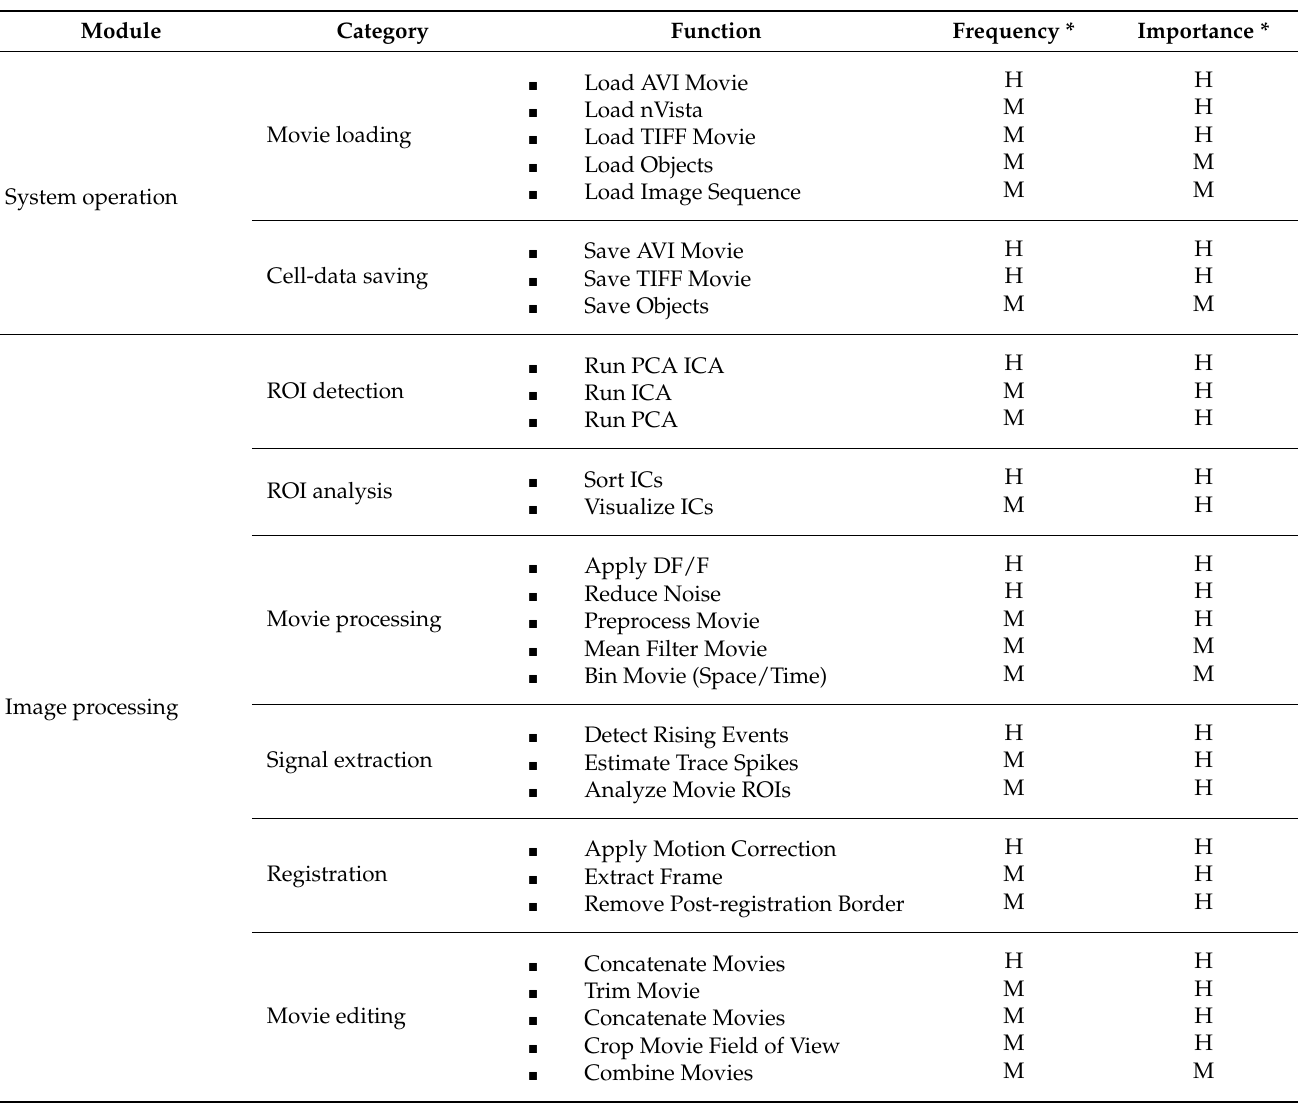
Table 1. Evaluation of frequency and importance of functions for an optical brain-machine interface (O-BMI)